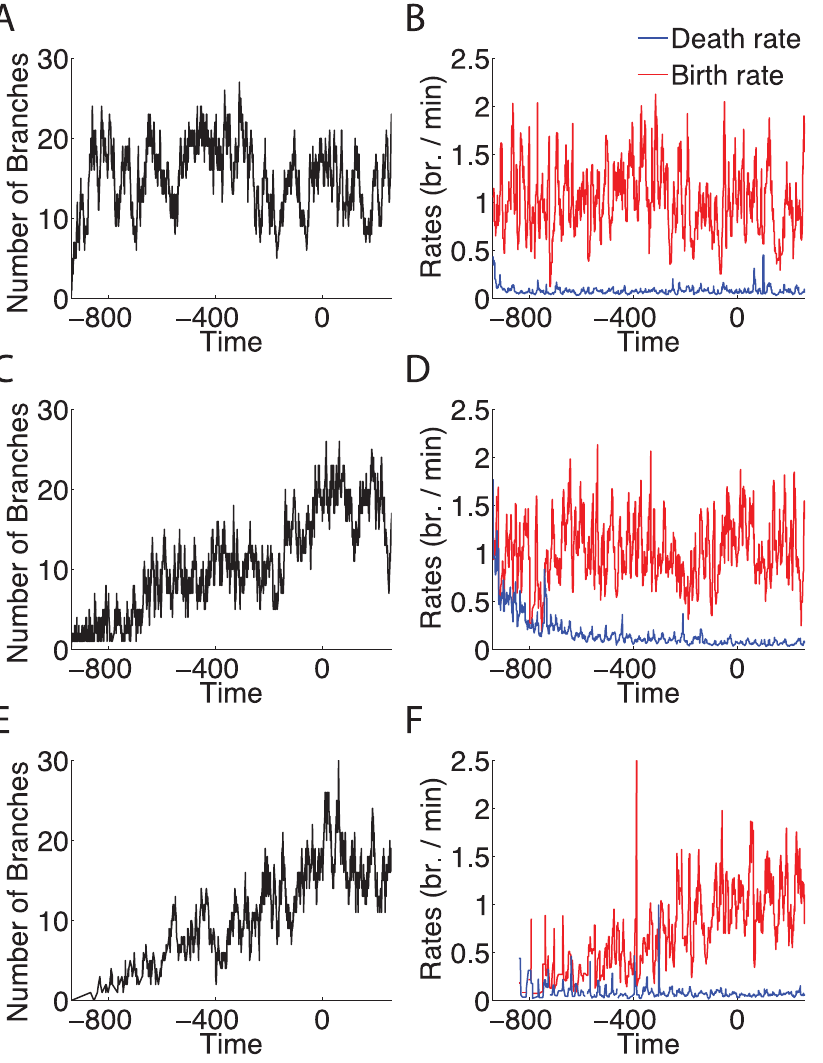
Fig 7. Simulations of simple birth-death processes showed that a changing birth rate and constant death rate are most consistent with the data. Each simulation had a forward transition rate of λ , and backward transition rate of μ i (where i is the number of branches). Time axis is relative to arrival at the TZ. Model 1: (A): Number of branches over time with constant arrival rate of 1 branch per minute, and constant death rate of 0.06 branches per minute. The number of branches reached steady state with a mean of 1/ 0.06 = 16.67 branches. (B): The estimated birth rate (red) and death rate (blue) for the simulated number of branches in Model 1. Model 2: (C): Number of branches over time with constant birth rate of 1 branch per minute, and death rate of 1/(0.0167 t ) for t < TZ and 0.06 for t (cid:3) TZ. (D): The estimated rates for the simulated branches in Model 2. Model 3: (E): Number of branches over time with constant death rate of 0.06 branches per minute, and birth rate of 0.001 t for t < TZ and 1 for t (cid:3) TZ. (F): The estimated rates for the simulated branches in Model 3. This simulation best reflects the observations from the experimental branch